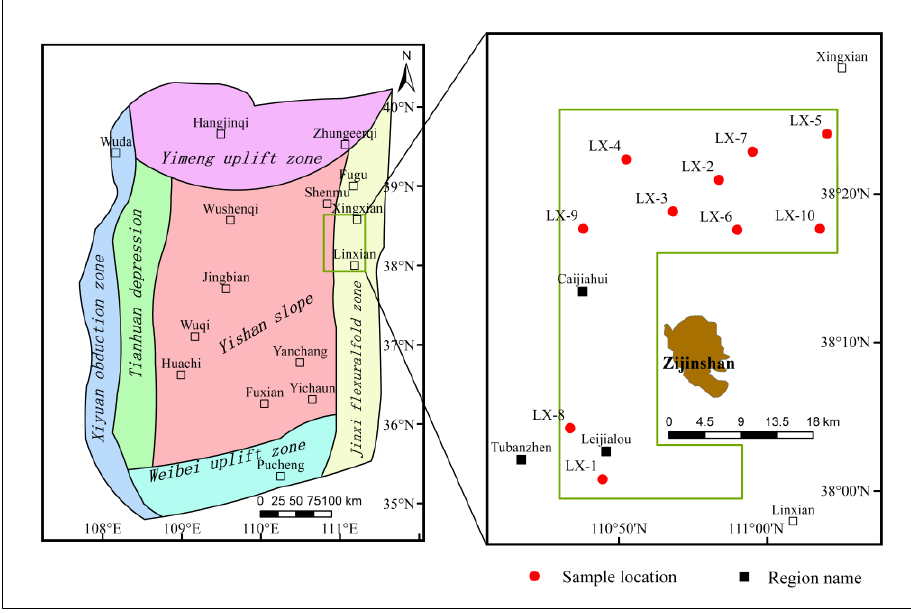
Figure 1. Geological background map of Lin-Xing area and sampling point distribution map. The mineral composition of the samples was determined using AXS D8